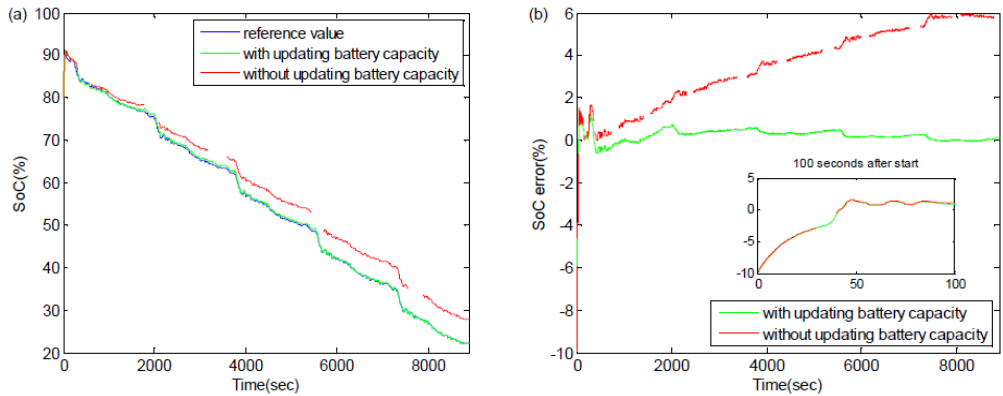
Figure 11. SOC estimation results in four states: ( a ) SOC estimation; ( b ) error of SOC estimation.